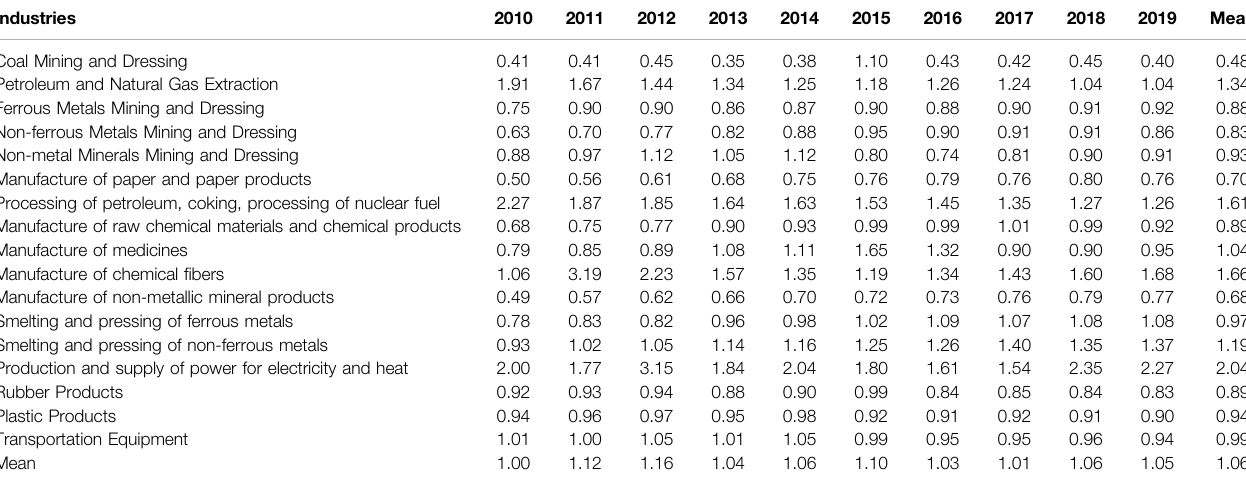
TABLE 3 | Results of the GIE in China ’ s industries.